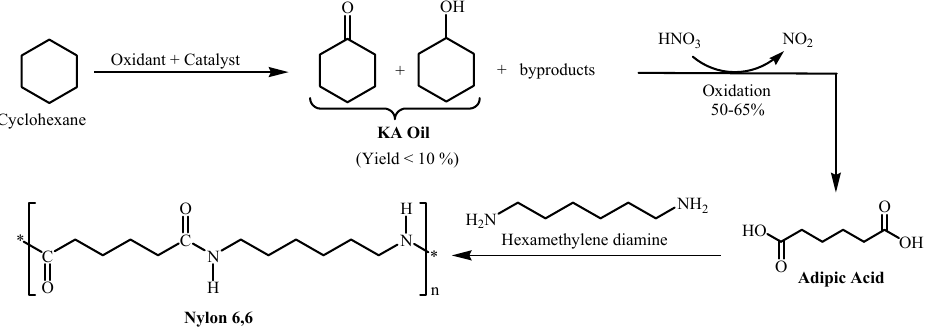
Figure 1. Synthesis pathway of nylon 6,6 from cyclohexane.